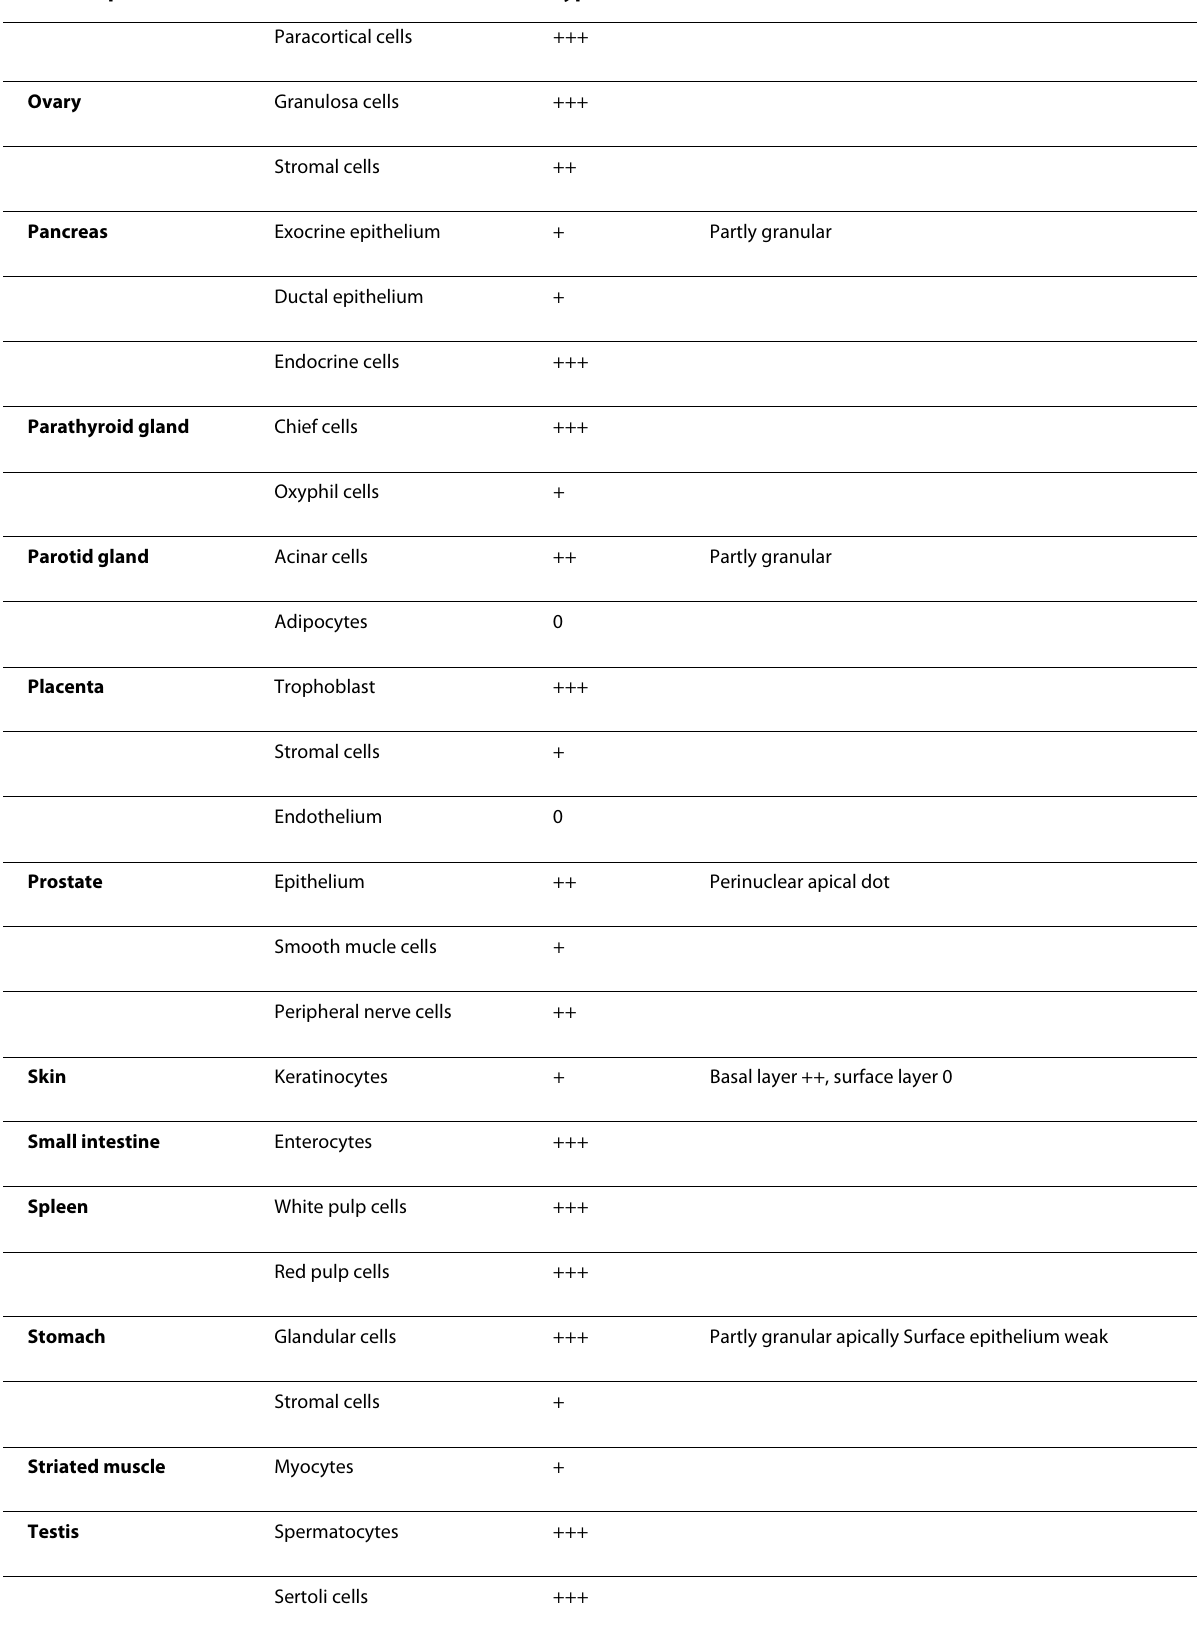
Table 1: Expression of FMNL2 in various tissues and cell types